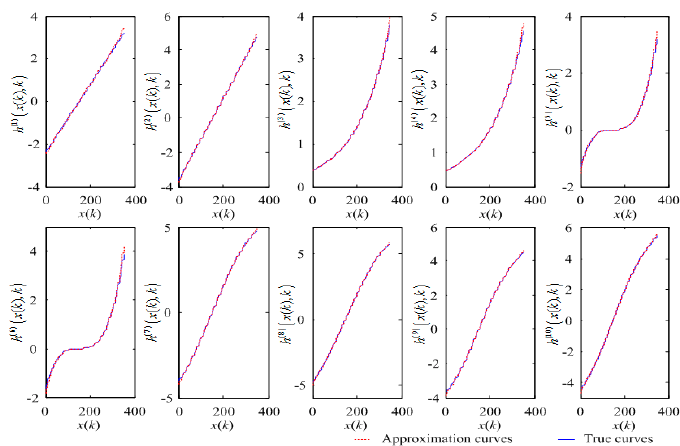
Figure 2. Approximation curves of nonlinear functions.